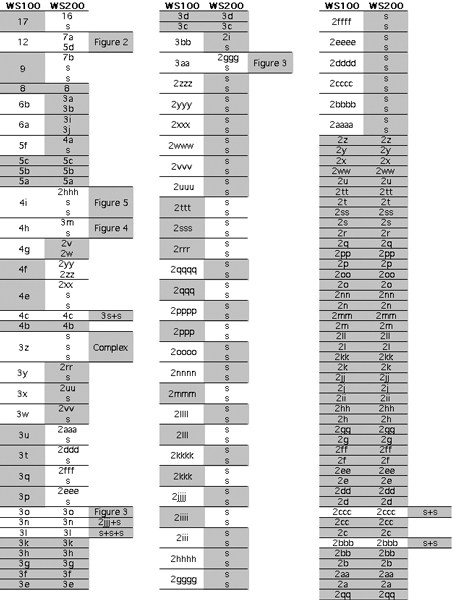
Relative Distribution of All Non-Singleton Clusters. Clusters are arranged in descending size according to WS100. Corresponding WS200 clusters are shown in the second column. Gray shaded clusters indicate UniGene agreement. Clusters designations correspond to cluster size with letters distinquishing between clusters of the same size, e.g., 6a and 6b refer to separate clusters of size 6. An s indicates a singleton (cluster of size one).